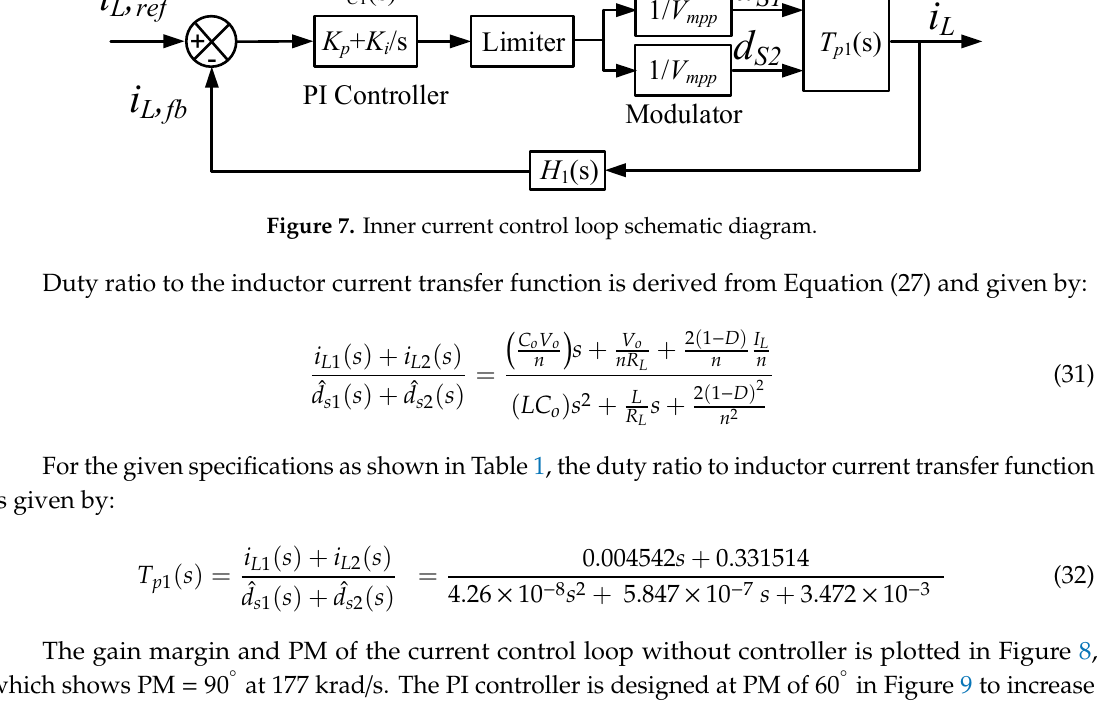
Figure 6. Pole-zero map of the control-to-output voltage transfer function of the system without controller.